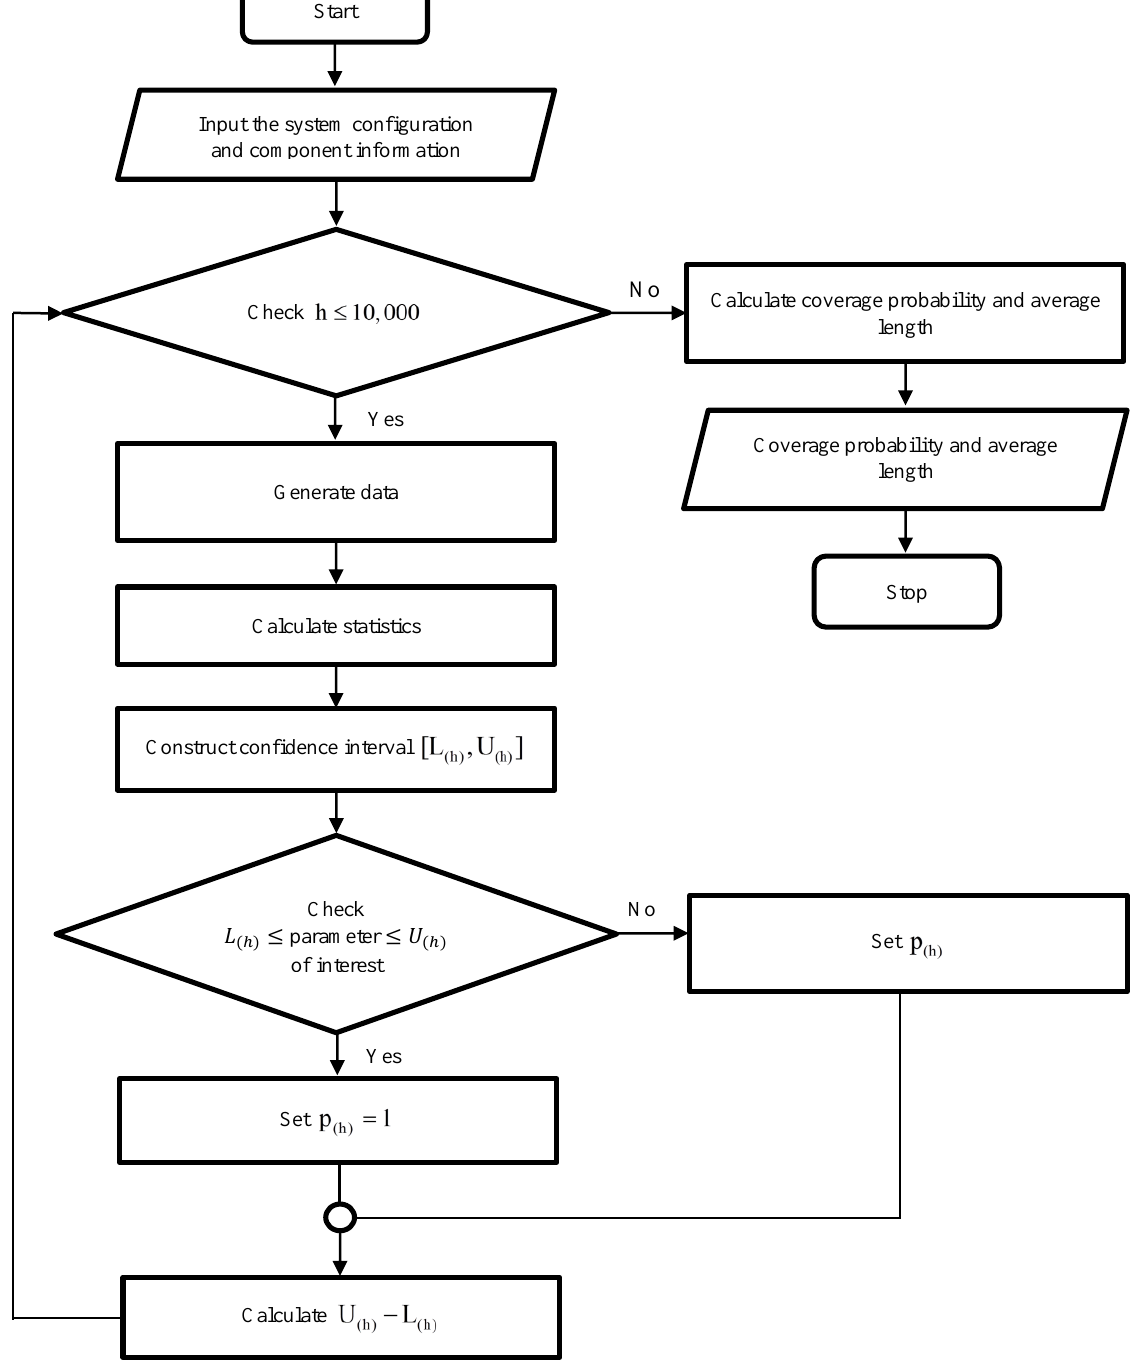
Figure 1. Monte Carlo simulation